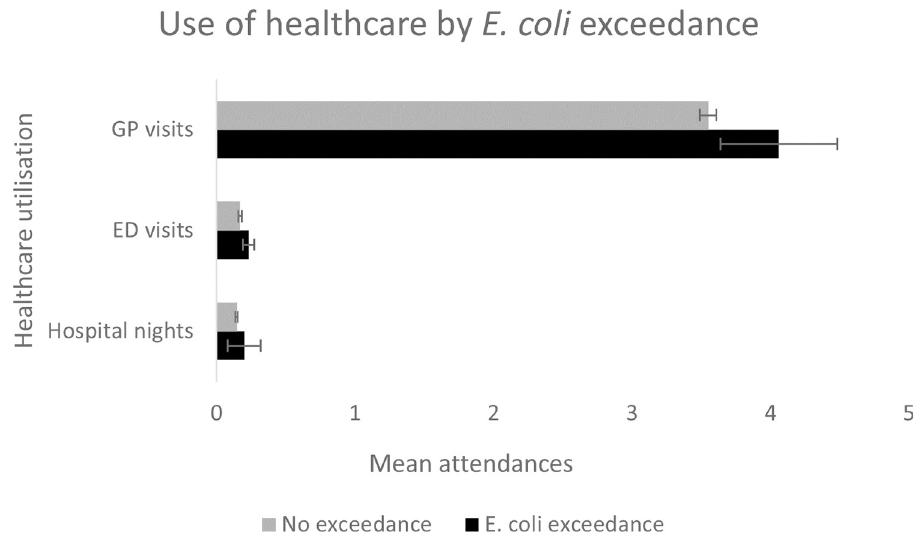
Fig 2. Use of healthcare by E . coli exceedance during preceding year at respondent’s